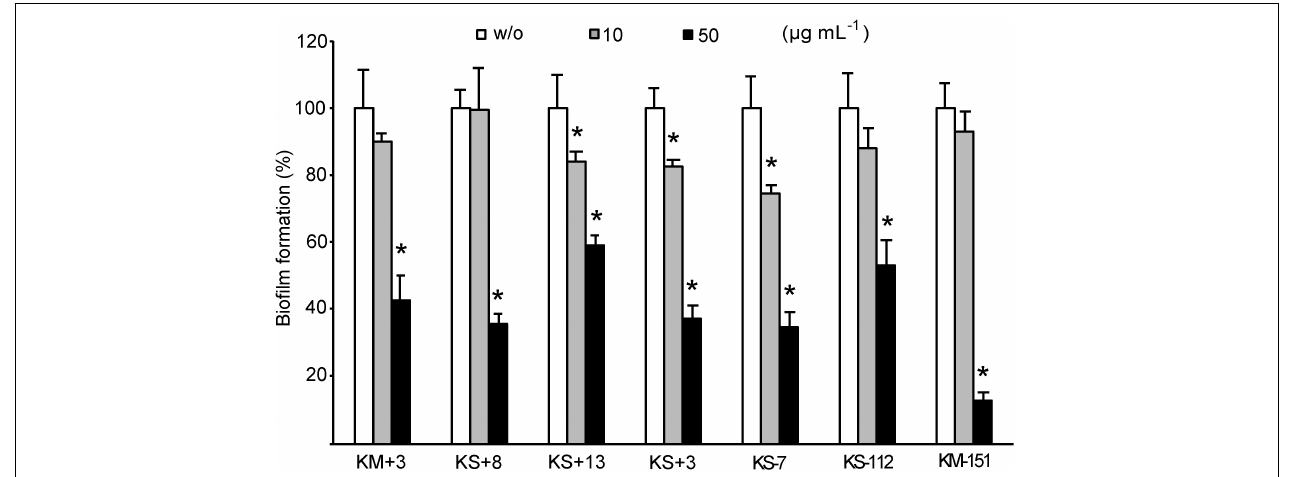
FIGURE 6 | Effects of YtnP-ZP1 on biofilm formation in environmental isolates. Values are plotted relative to buffer-treated control (w/o) and are representative of three independent experiments ± SD. * P < 0.05.